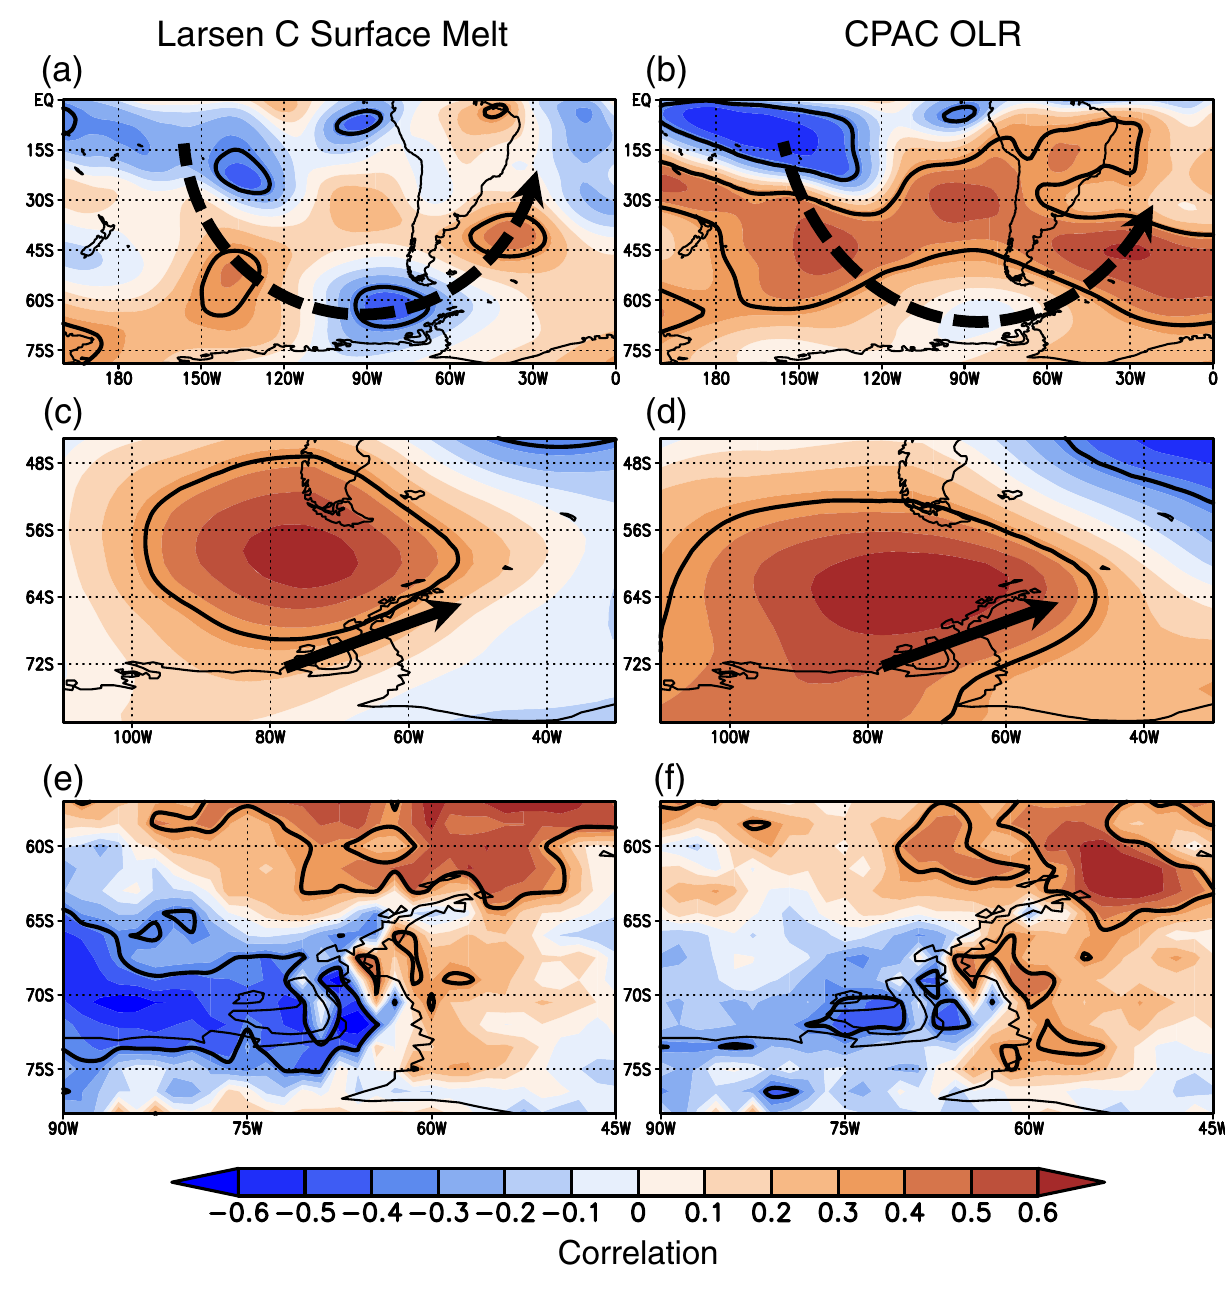
Fig. 2 The atmospheric circulation anomalies associated with CPAC convection compared to Larsen C surface melt. The DJFM detrended correlation (shaded), 1991 – 2015, of (left; ( a , c , e ) Larsen C surface melt and (right; ( b , d , f ) CPAC OLR with a , b 250 hPa streamfunction, c , d 500 hPa geopotential height, and e , f vertically integrated moisture fl ux divergence. Correlations signi fi cant at p < 0.10 are denoted by bold black contours. CPAC OLR correlations are multiplied by − 1 to re fl ect anomalies associated with enhanced CPAC convection. Dashed black arrows in a , b schematically show the path of Rossby wave propagation. Solid black arrows in c , d schematically show anomalous winds across the AP associated with the Drake Passage anticyclonic circulation